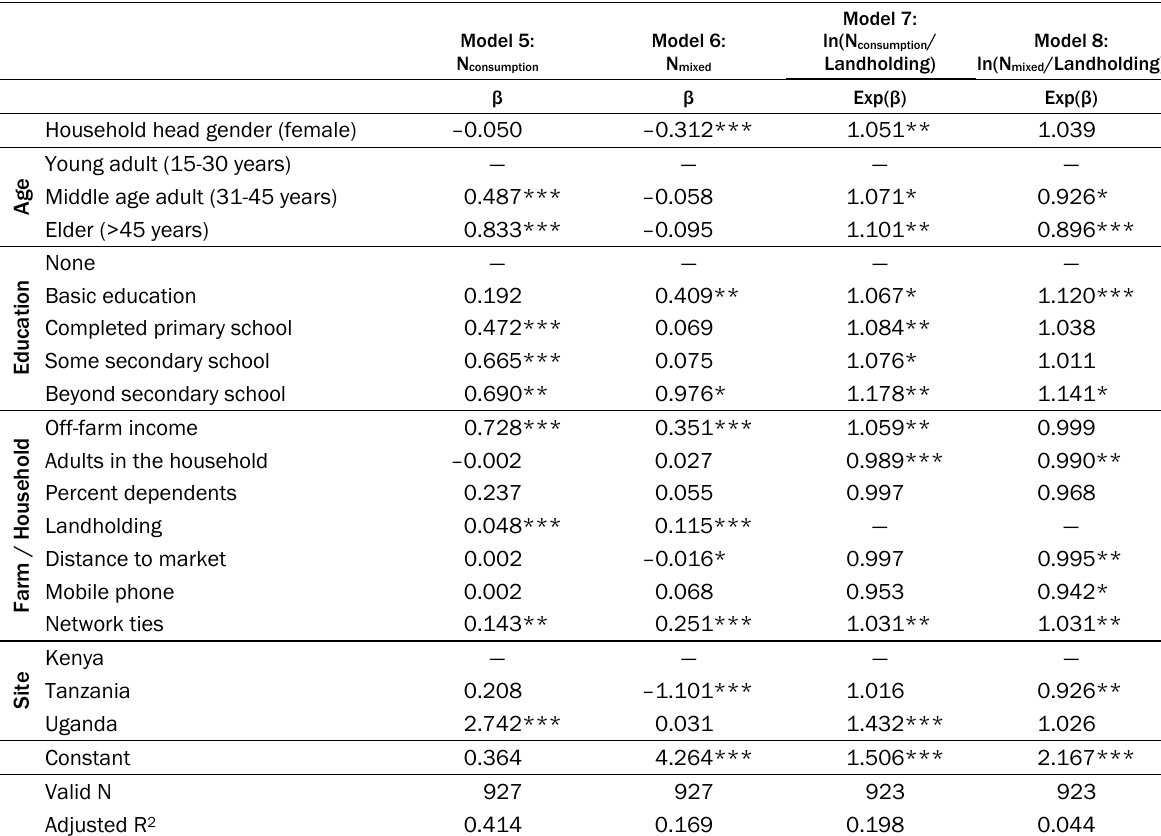
Table 8. Correlates of Staple Food Versus Mixed Food-Income Crops